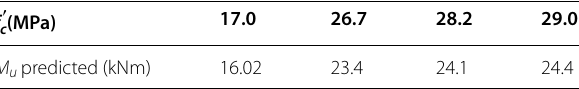
Table 9 Variation of M u predicted as a function of f ′ c for a higher dosage of SFRC